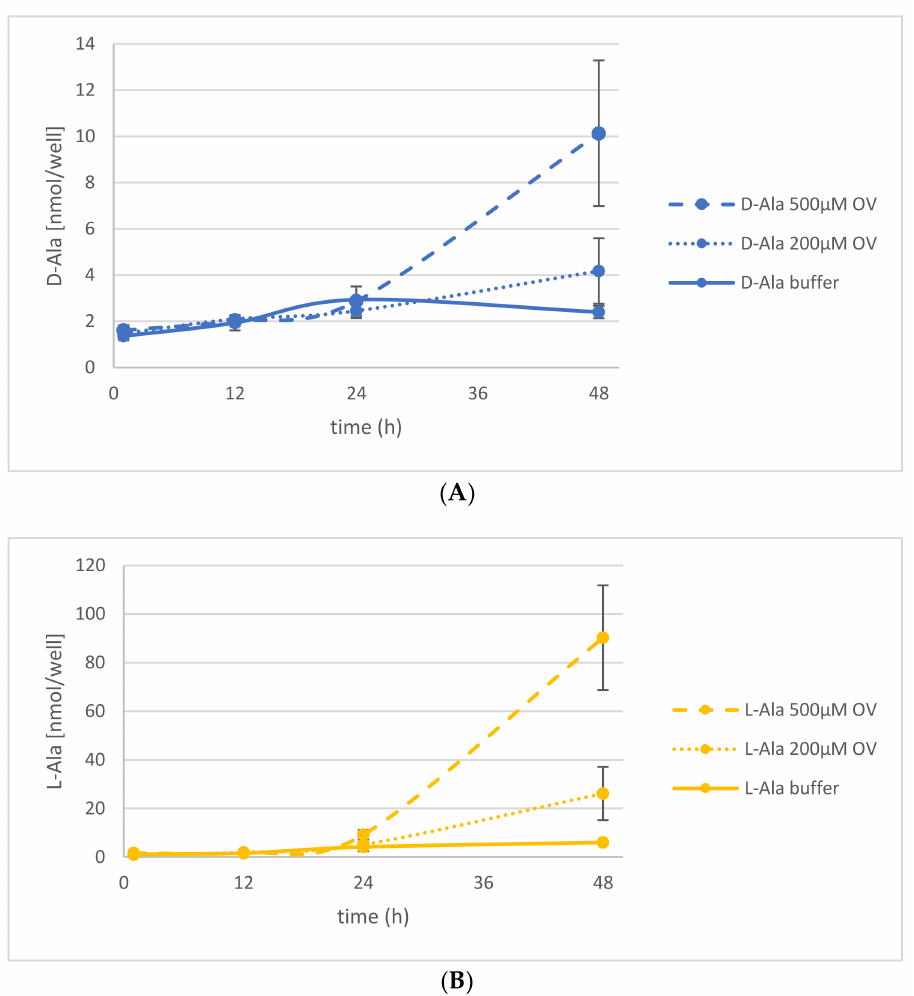
Figure 4. Release of D - and L -Ala into the medium under Na-orthovanadate (OV) treatment. Seedlings were treated with D -Ala and then transferred to fresh medium without OV (solid line), with 200 µ M OV (dotted line), and with 500 µ M OV (dashed line). Then, the D -Ala ( A ) and L -Ala ( B ) contents in the media were analyzed from 1 to 48 h after transfer. Error bars: ±